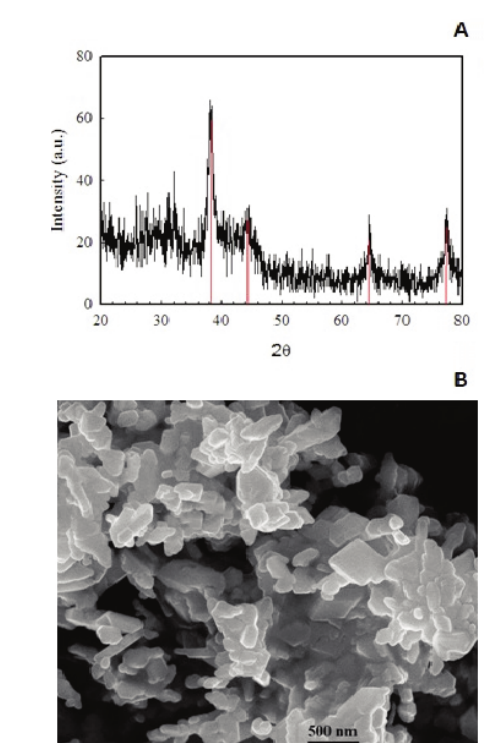
Fig. 3 ­ The XRD patterns of the C. myxa synthesized AgNPs (A) (Left), and electron microscopic scanning image of chemical 3 AgNPs